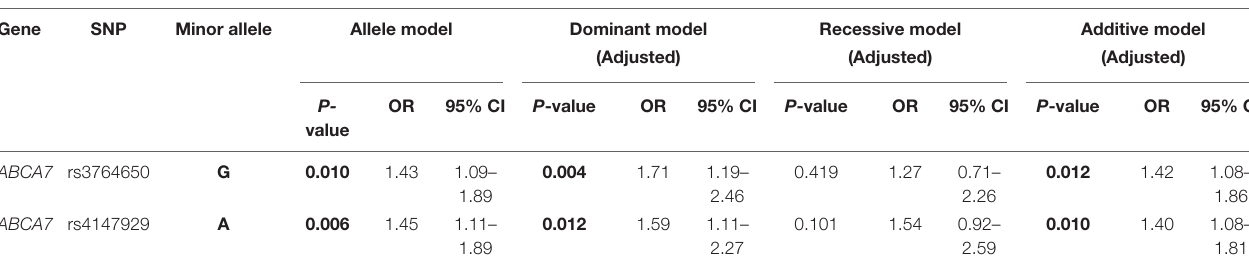
TABLE 3 | Association of SNPs of candidate genes and odds ratio to AD